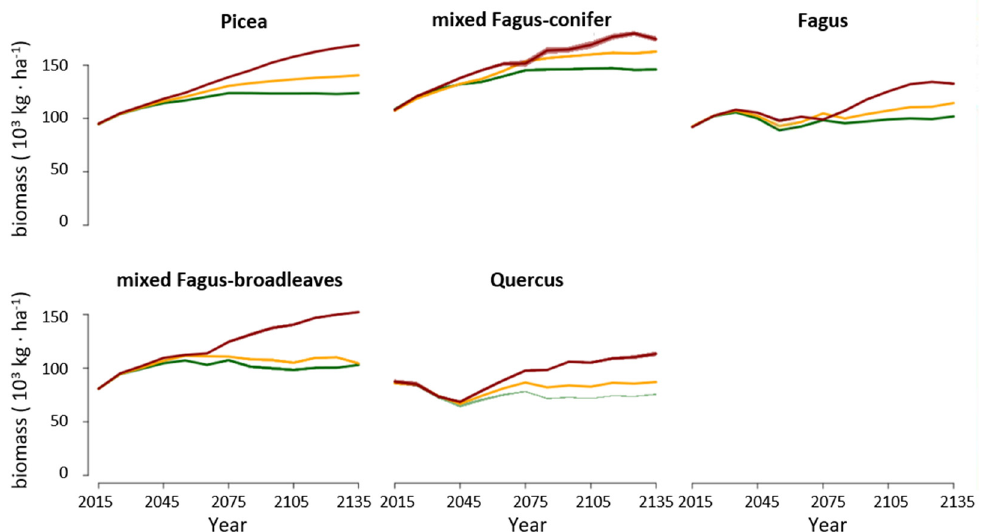
Figure 5. Mean (dashed line) and 95% confidence interval (shaded area) of the living biomass ( − 10 3 kg · ha − 1 ) measured in the forest belts over time under the three climate change scenarios: RCP 2.6 (green), RCP 4.5 (orange) and RCP 4.5 (red).